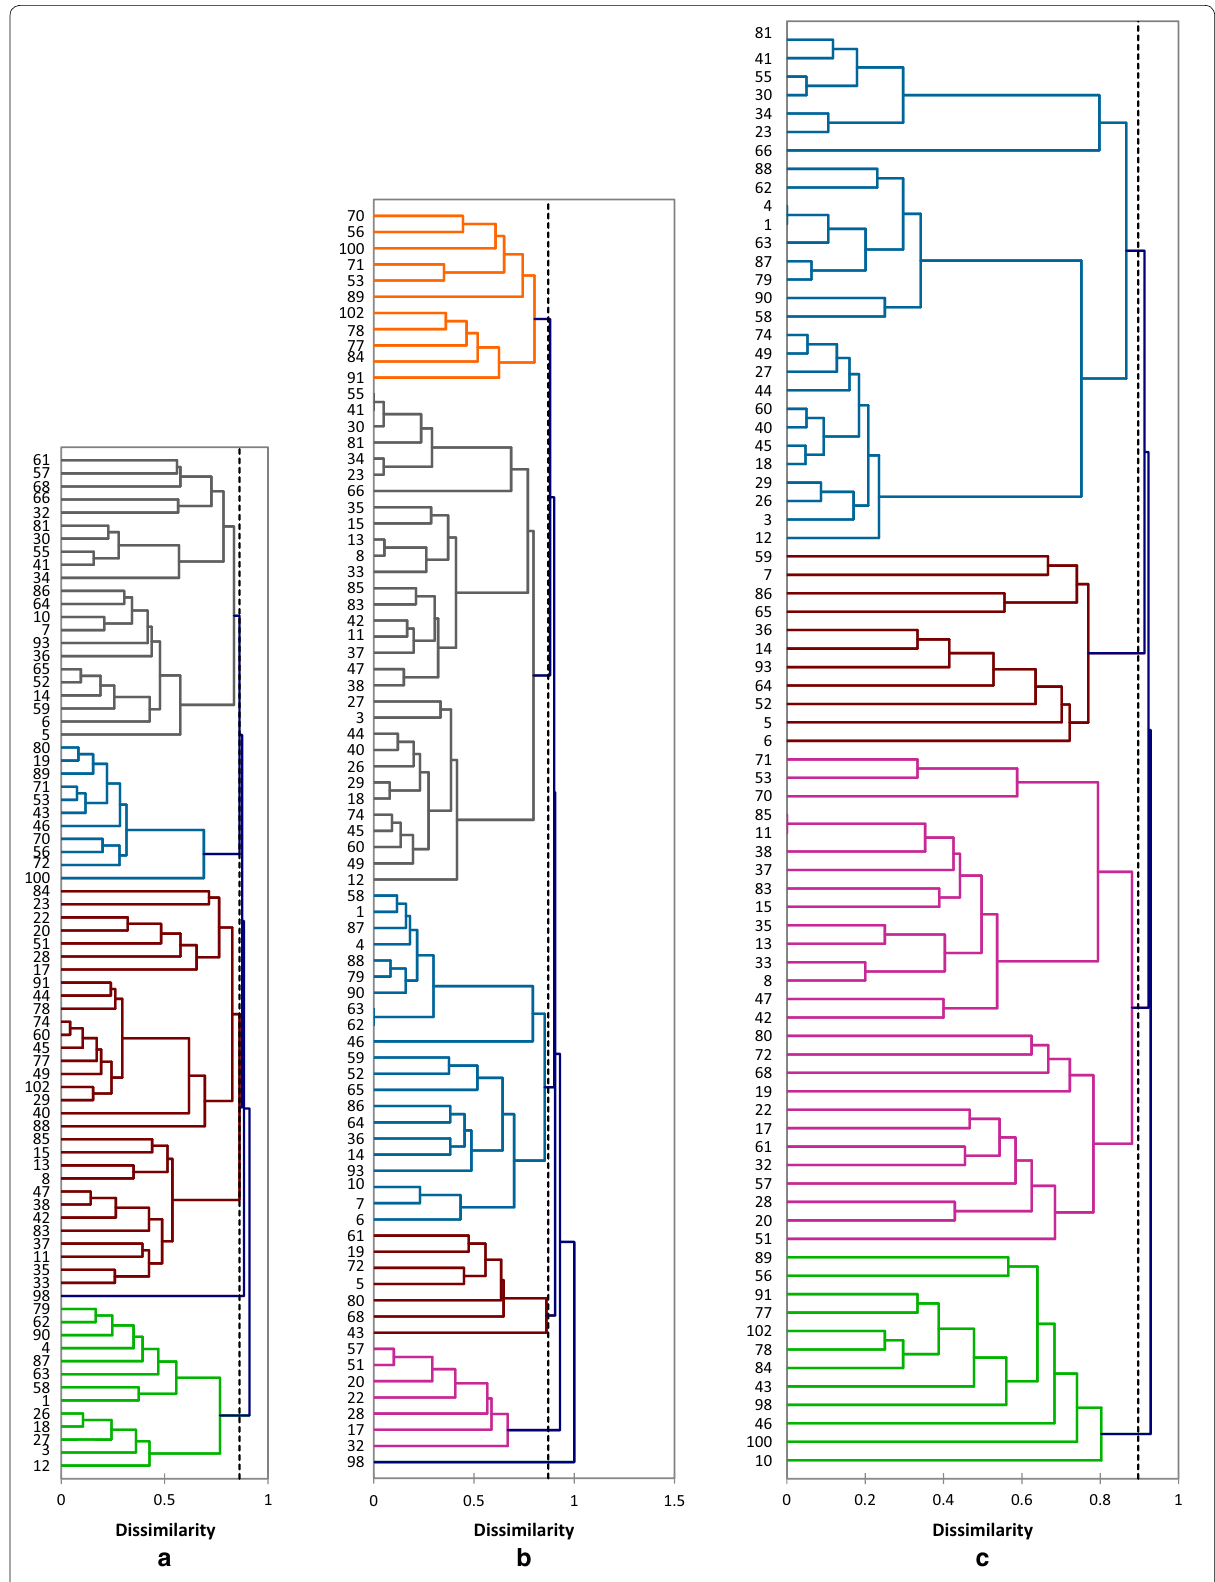
Fig. 3 Dendrograms generated using UPGMA cluster analysis and Jaccard’s index based on seed proteins diversity of 78 Vicia accessions. a Albu- mins, b globulins, c